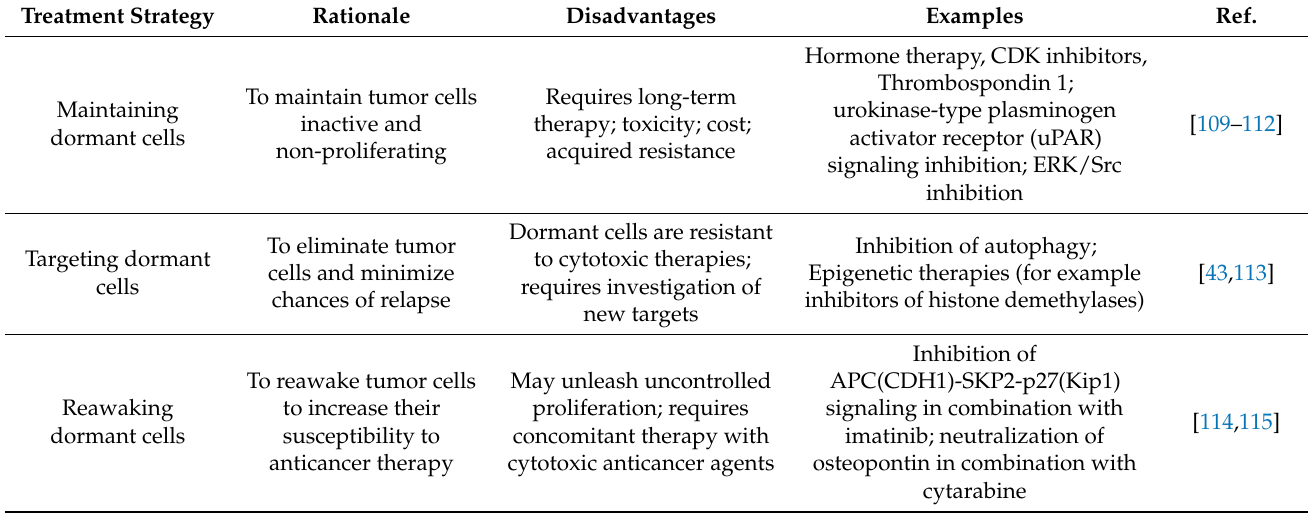
Table 1. Suggested therapeutic strategies regarding tumor dormancy.